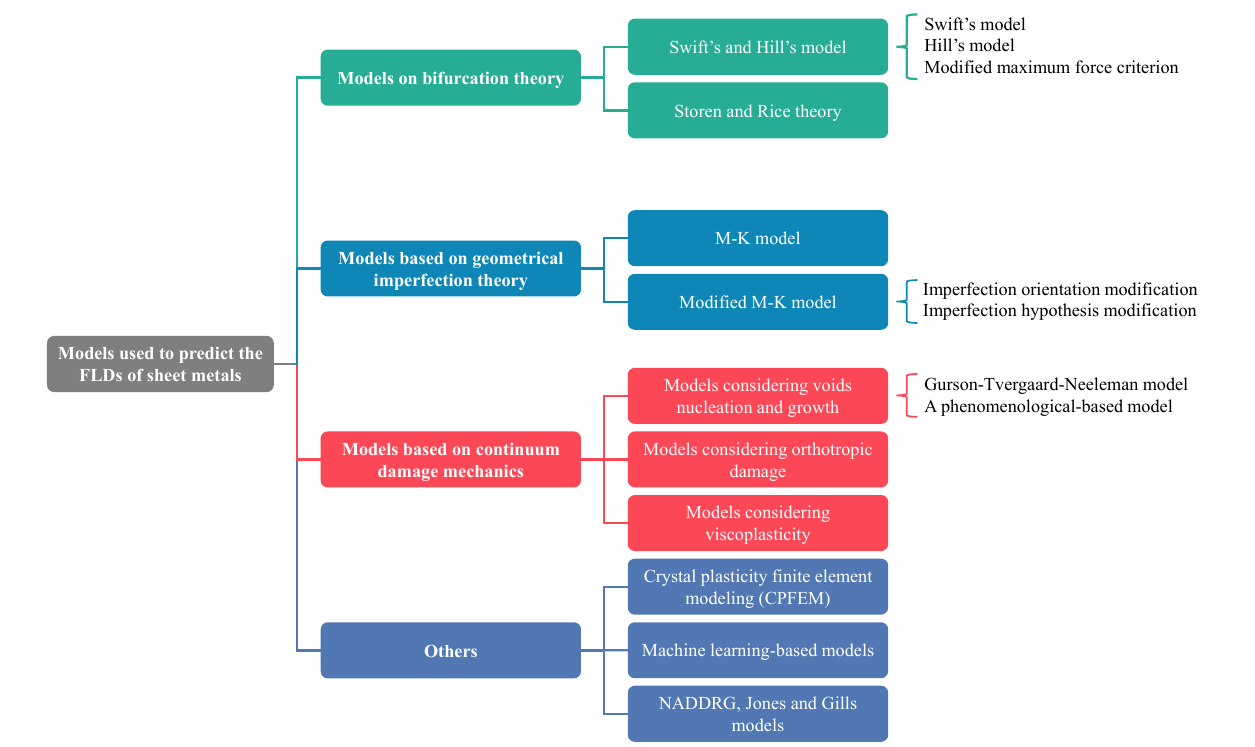
Figure 28. Theoretical and numerical models used for formability prediction.